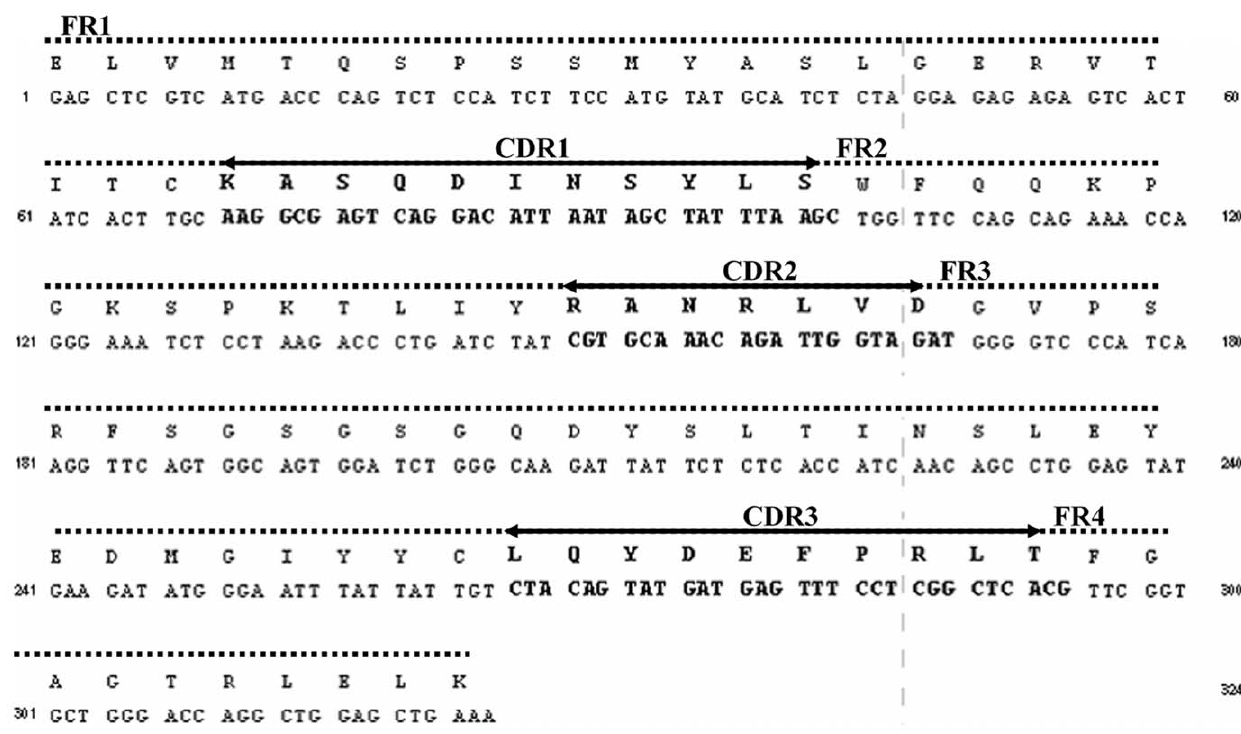
Figure 2. Nucleotide and aminoacid sequences of mAb 4C5. Nucleotide and amino acid sequences of the L-chain variable region of mAb 4C5.